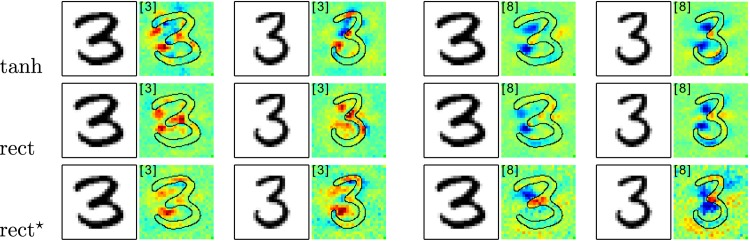
Evidence for a handwritten digit being a “3” or a “8”.Classifying as “3” is supported by the middle horizontal stroke featured in this digit and the absence of vertical connections on the left of the image. Evidence for being a “8” feature again the middle horizontal stroke, however, the absence of connections on the left side of the digit constitutes negative evidence. Explanations are again stable for various models and samples.